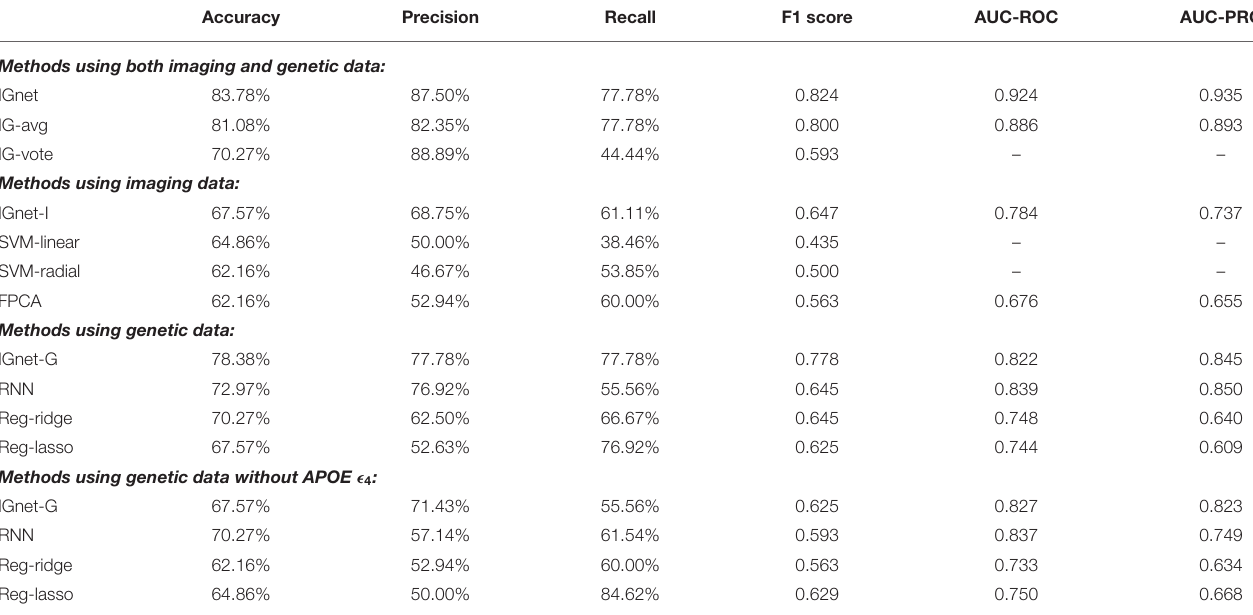
TABLE 1 | Comparison of the performance of IGnet on the ADNI data set. AUCs are not available for the IG-vote, SVM-linear, and SVM-radial methods, therefore, are not presented. Accuracy Precision Recall F1 score AUC-ROC